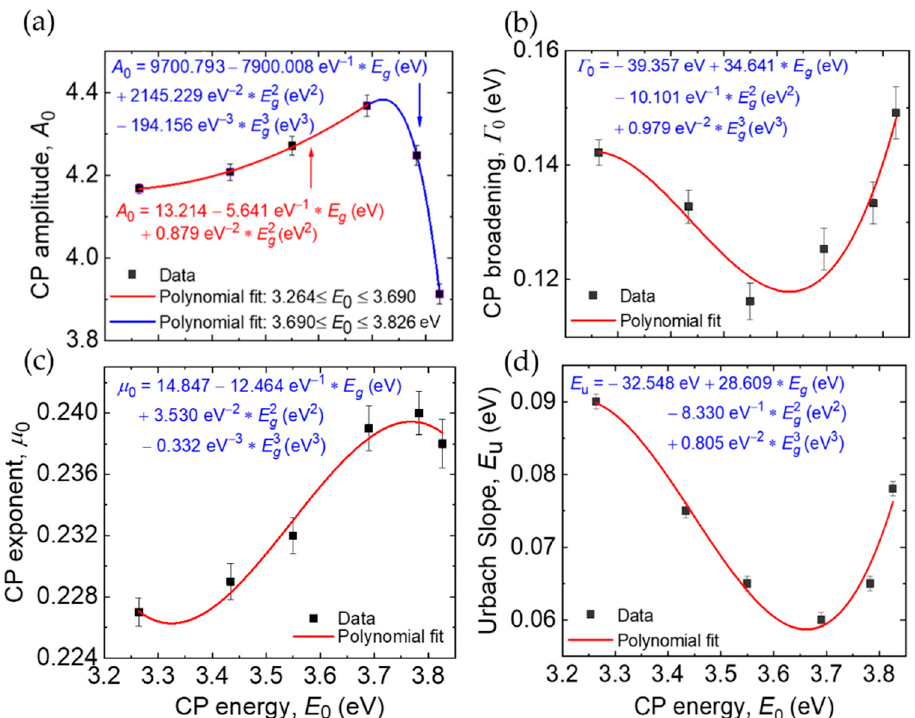
Figure 5. Best fitting variable parameters of lower energy CP ( a ) amplitude, ( b ) broadening, and ( c ) exponent, as well as the ( d ) Urbach slope representing the MZO dielectric function according to Equations (1) and (2). Table 2. Polynomial expressions in terms of bandgap CP energy E 0 = E g for the four variable optical parameters along with values for the single linked and seven fixed optical parameters deduced in NIR-UV spectroscopic ellipsometry analyses of SLG/MZO samples. The information in this table along with Equations (1) and (2) can be applied to predict the dielectric function of Mg x Zn 1 − x O for any specified value of E g within the range 3.264 eV ≤ E g ≤ 3.826